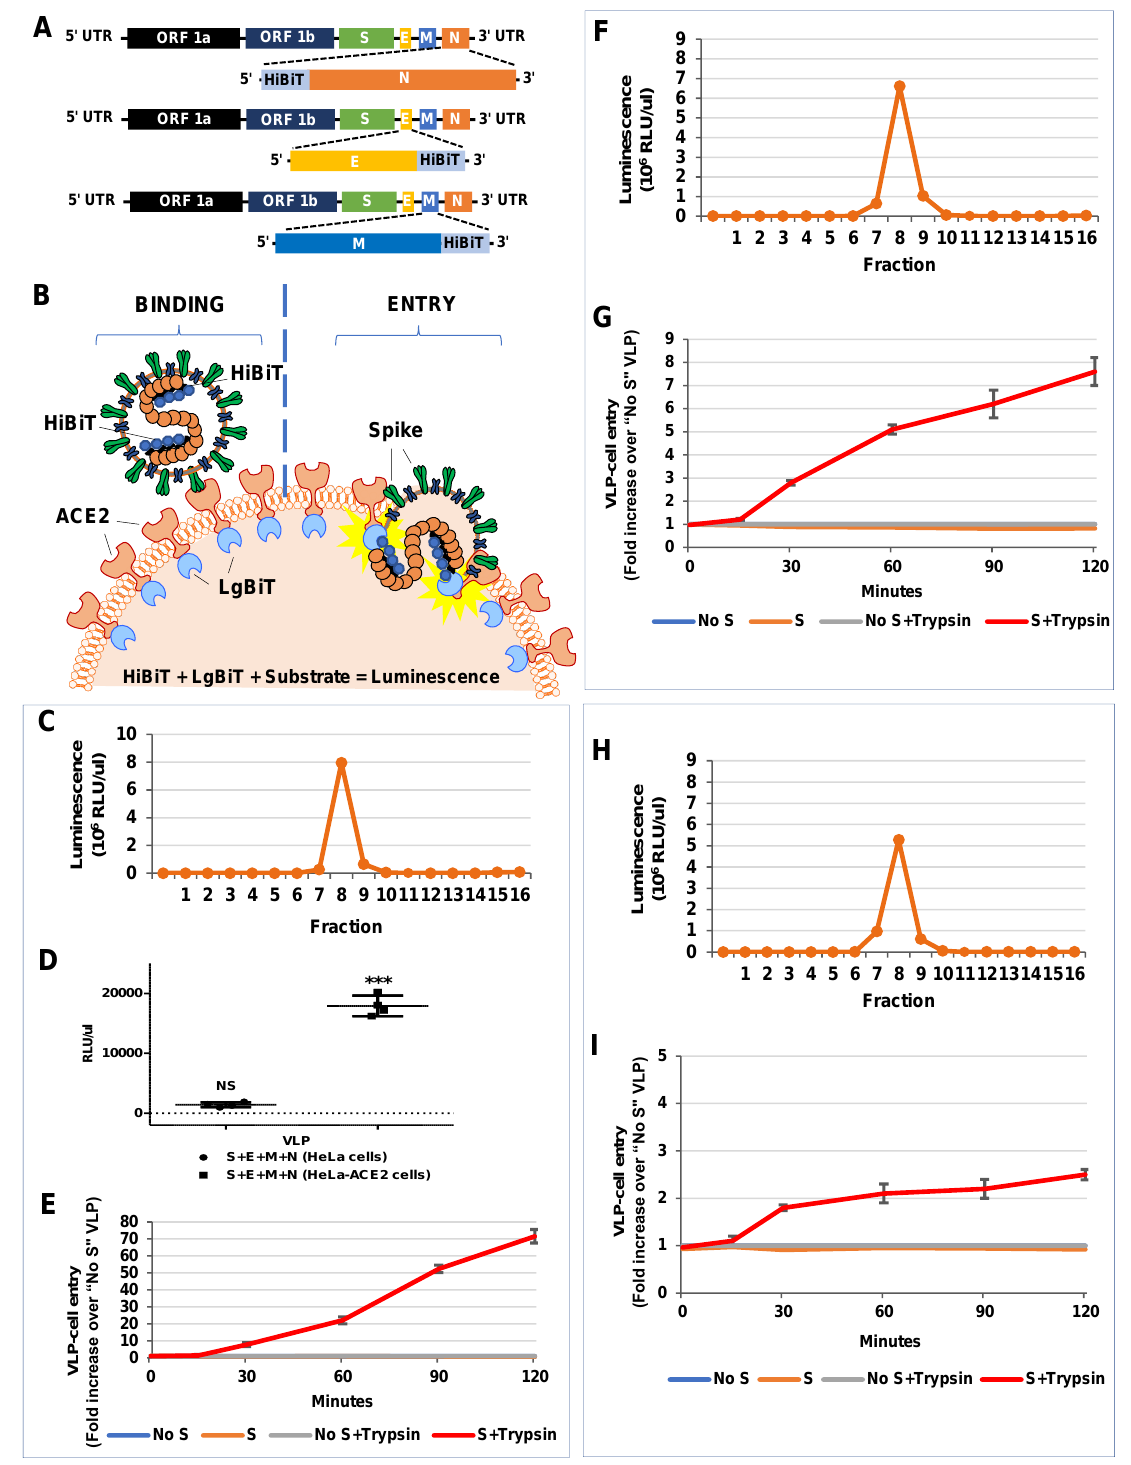
Figure 6. VLP binding and entry into target cells. ( A ) Schematic representation of the SARS-CoV2 HiBiT-N, E-HiBiT, and M-HiBiT constructs. HiBiT peptides were appended to the C-termini of E and M proteins. ( B ) Schematic depicting VLP binding (left) and entry (right) into target cells. VLPs bind to ACE2 receptors that have LgBiT appended to cytoplasmic C-termini. HiBiT-LgBiT complementation and development of Nluc measures successful VLP entry. ( C ) SEC elution profile depicting HiBiT-N VLPs in fractions 7–9. ( D ) VLP-cell binding; HeLa or HeLa-ACE2 cells were incubated with Nluc-N VLPs for 1.5 at 4 ◦ C. VLPs were with or without S proteins; the VLPs lacking S served as controls. Cell-associated Nluc